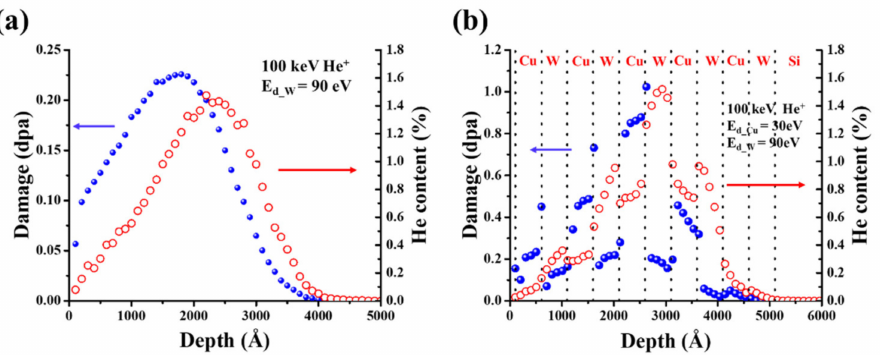
Figure 1. The irradiation damage and helium content profiles of: ( a ) W; ( b ) W/Cu-50, with the He implanted dose of 2 × 10 16 ions/cm 2 calculated by